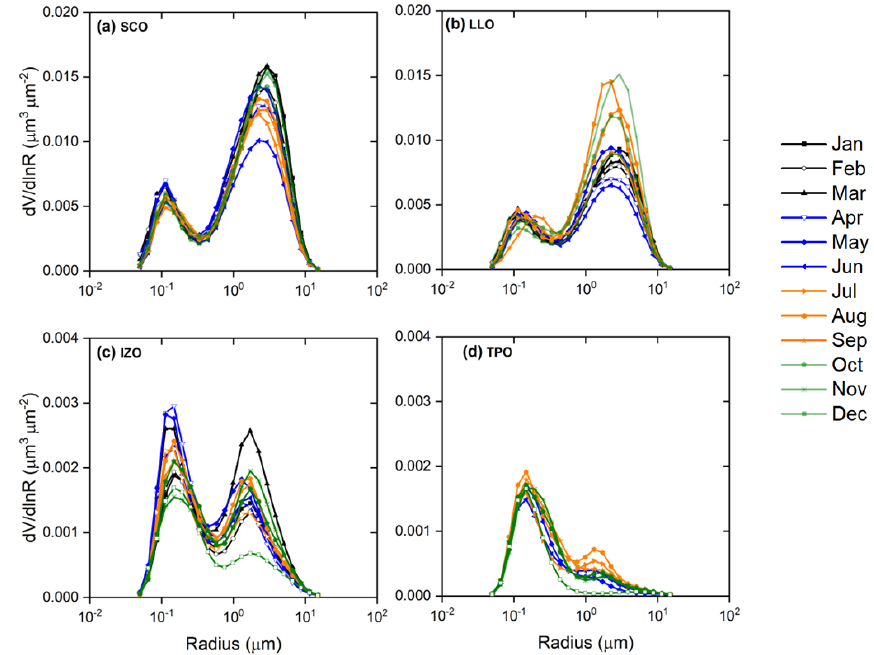
Figure 5. Monthly mean aerosol particle size distributions at (a) SCO, (b) LLO, (c) IZO and (d) TPO under background